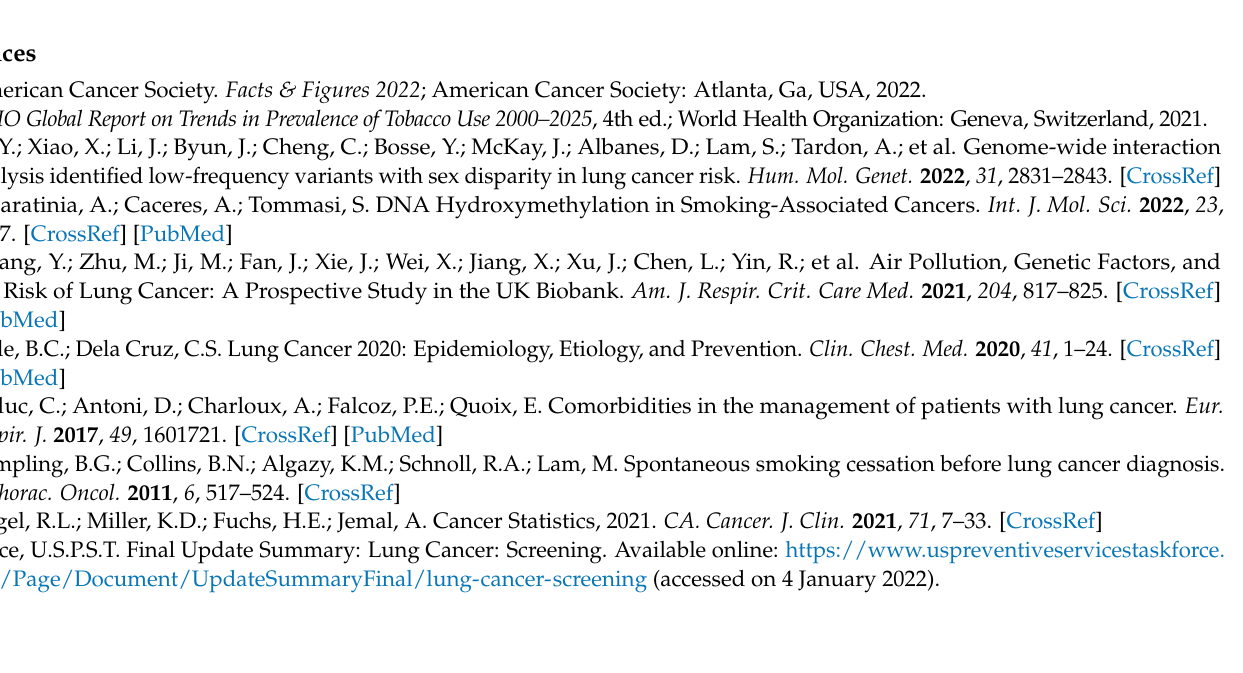
Table S2—genes included in enriched pathways; Figure S1—qRT-PCR analysis of spike-in controls for cfRNA isolation across